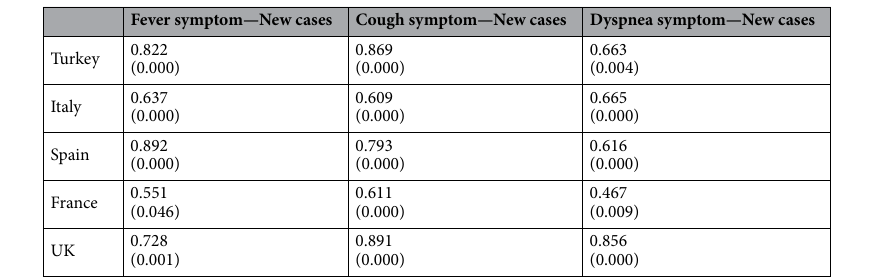
Table 4. DCC between symptoms and cases. p-values are shown in